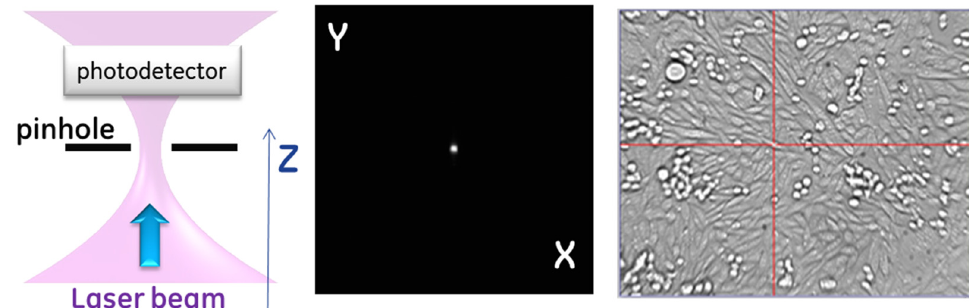
Figure 2. Illustration of beam alignment. ( Left ) First, the laser was aligned to pass through the 2 µ m pinhole by maximizing the photocurrent on a photodetector that responds to the operating wavelength (1550 nm, InGaAs). ( Middle ) The pinhole was focused on the CCD camera and ( Right ) image as seen on the computer screen that controls the experimental setup for a test on CHO cells showing the ( X , Y ) position that was recorded (red cross). This method also permits optimizing Z , since high-numerical aperture (NA) objectives diverge light rapidly, and only a narrow range of Z allows passing the entire beam through the pinhole. ( Right ) Example of the user experience in selecting and permeabilizing the cell of interest by placing the red cross on the desired